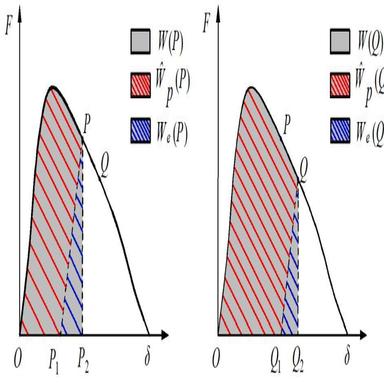
The schematic of the work W done by the external force, the plastic dissipation ̂Wp by plastic deformation and the critical elastic strain energy storage We at two arbitrary positions P and Q during crack propagation in elastic-plastic materials.